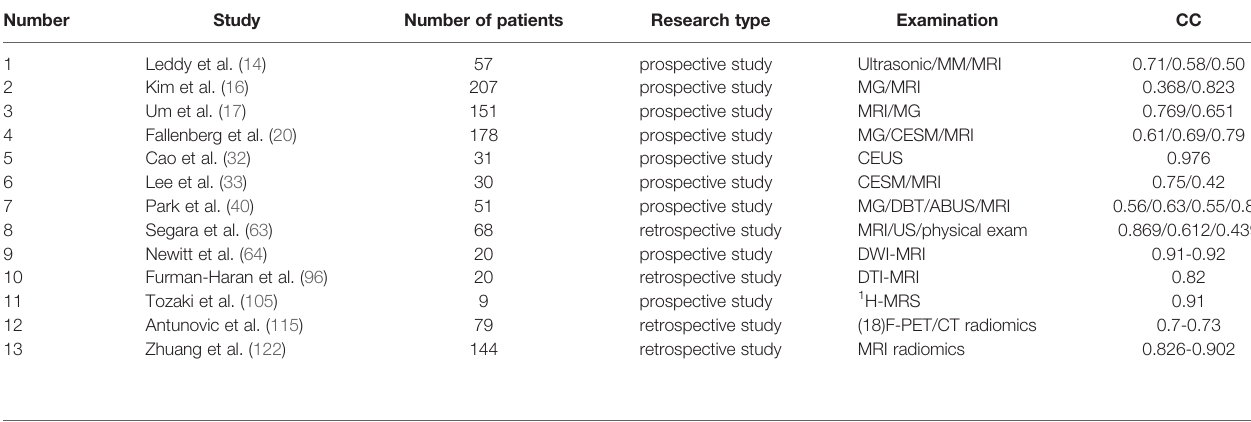
TABLE 1B | Studies on the ef fi cacy of various imaging techniques for breast cancer NAC (References to this article) (B) Studies on the ef fi cacy of various imaging techniques on breast cancer NAC [evaluation index: correlation coef fi cient (CC)].